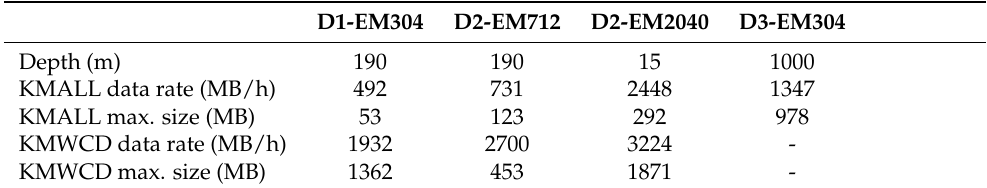
Table 1. Data rates, depth and maximum file sizes for the datasets used in this